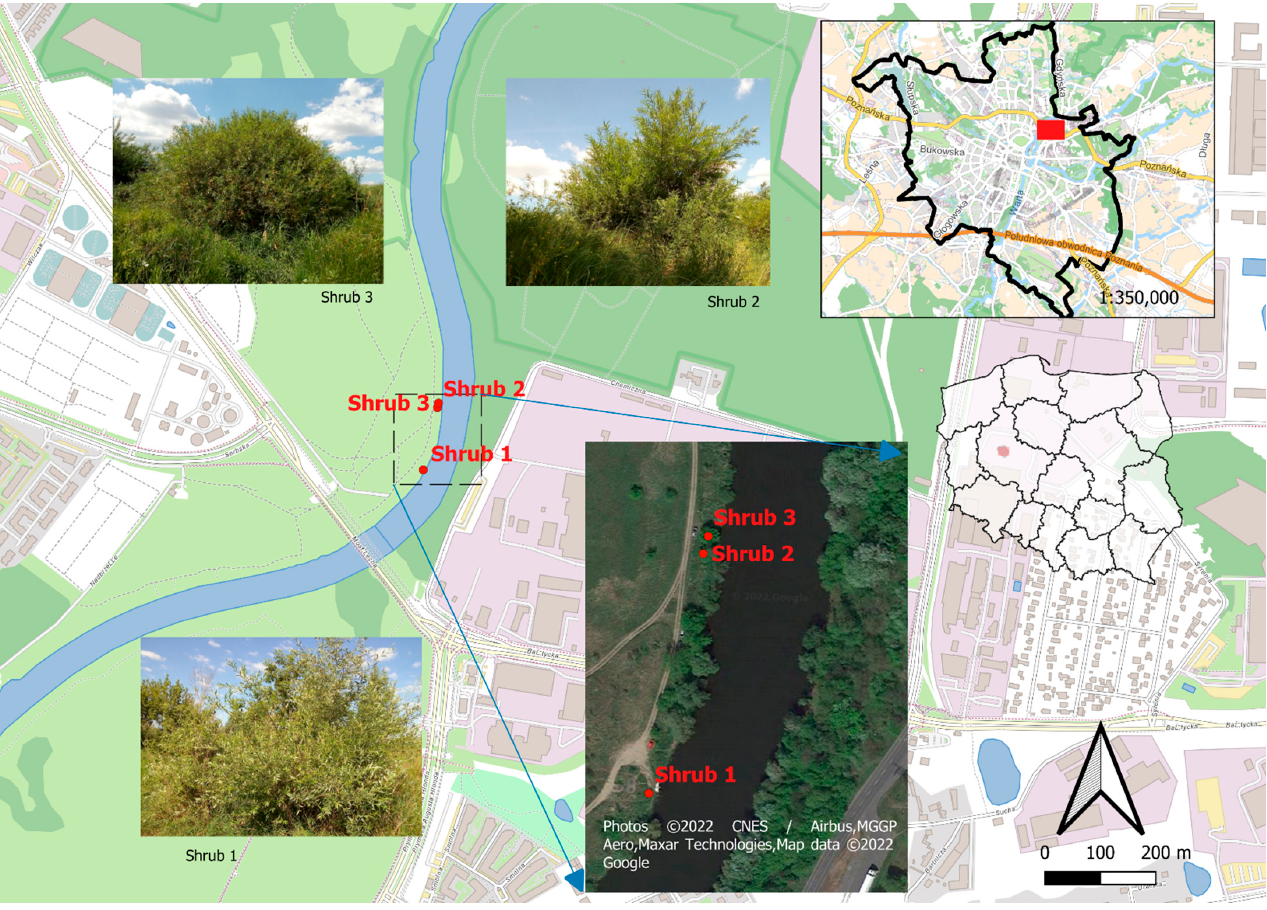
Figure 1. Illustrative map with locations of individual shrubs.